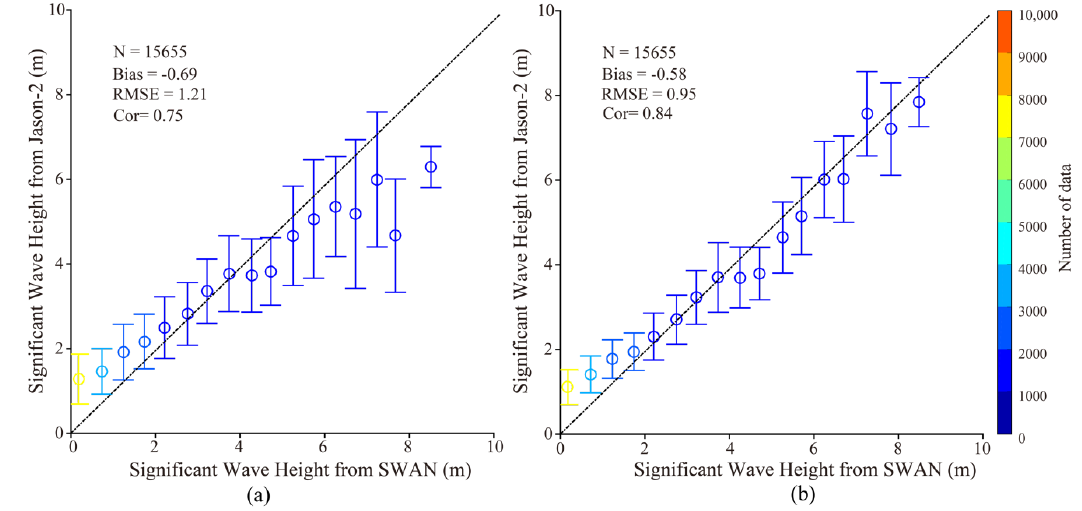
Figure 14. Comparison between significant wave heights simulated by the SWAN model and the measurements from the Jason-2 altimeter for a 0.14-m bin between 0 and 9 m, in which the error bars represent the standard deviation at each bin: ( a ) without the sea-water level term; ( b ) with the sea-water level term. Table 3. Comparison between the results from the SWAN model and the moored buoys.